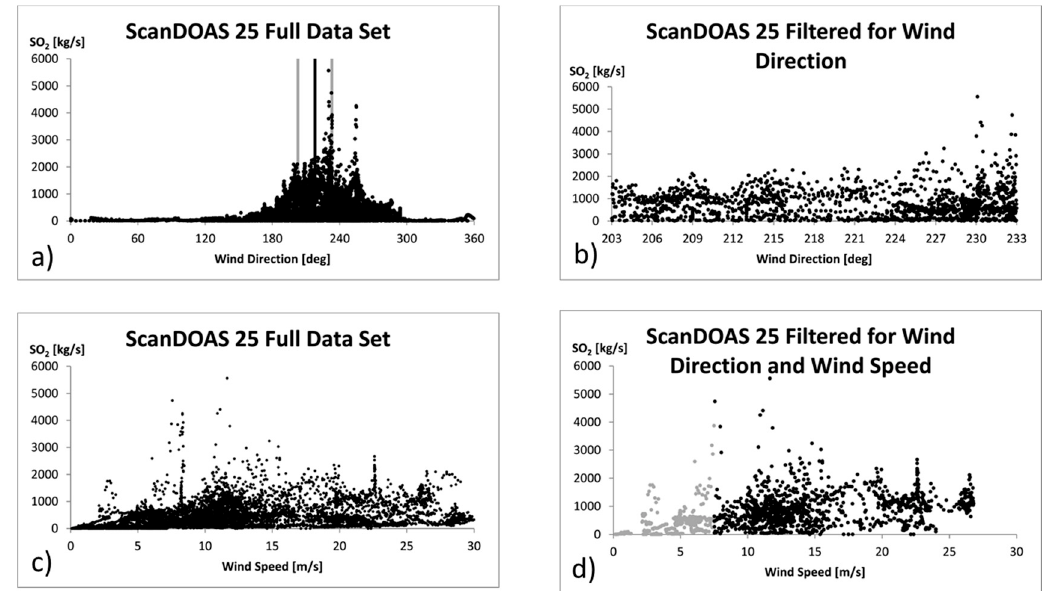
Figure 3. ( a ) Impact of wind direction on SO 2 flux. The vertical black line shows the direct line of sight from the main eruption vent to the instrument. The vertical gray lines show the direct line of sight ± 15 ◦ ; ( b ) SO 2 flux filtered for wind direction; ( c ) Impact of wind speed on SO 2 flux; ( d ) SO 2 flux filtered for wind direction and wind speed. The measurements in gray were made at weak wind speeds and have been filtered out.